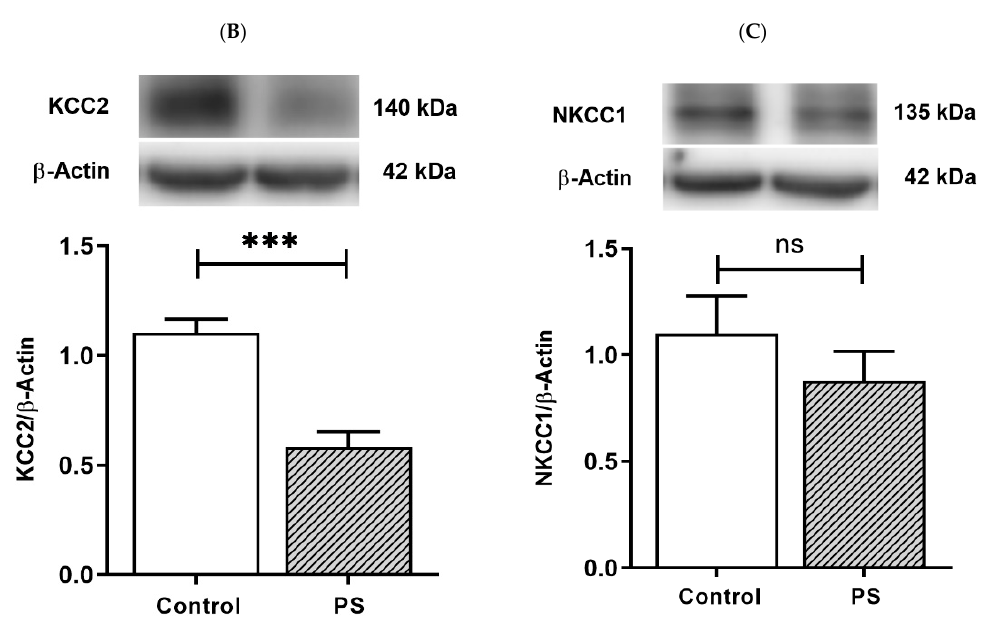
Figure 2. Developmental shift of cation–chloride cotransporters. ( A ) Immunohistochemical staining of KCC2. Expression in the medial prefrontal cortex between the control (left) and prenatal stress (PS) (right) groups; white arrows indicate KCC2-positive cells (upper; red) merged with the nuclear stain DAPI (lower; blue), scale bar = 20 µm. ( B ) Western blotting of KCC2. Upper, band comparing the control (left) and PS (right) groups; lower, bar graph displays the analysis of protein band densities of the KCC2/ß–actin ratio; the significant differences at *** p < 0.001. ( C ) Western blotting of NKCC1. Upper, band comparing the control (left) and PS (right) groups; lower, bar graph displays the analysis of protein band densities of the NKCC1/ß–actin ratio; non-significance (ns) was found. Data are shown as the mean ± SEM, n = 5.